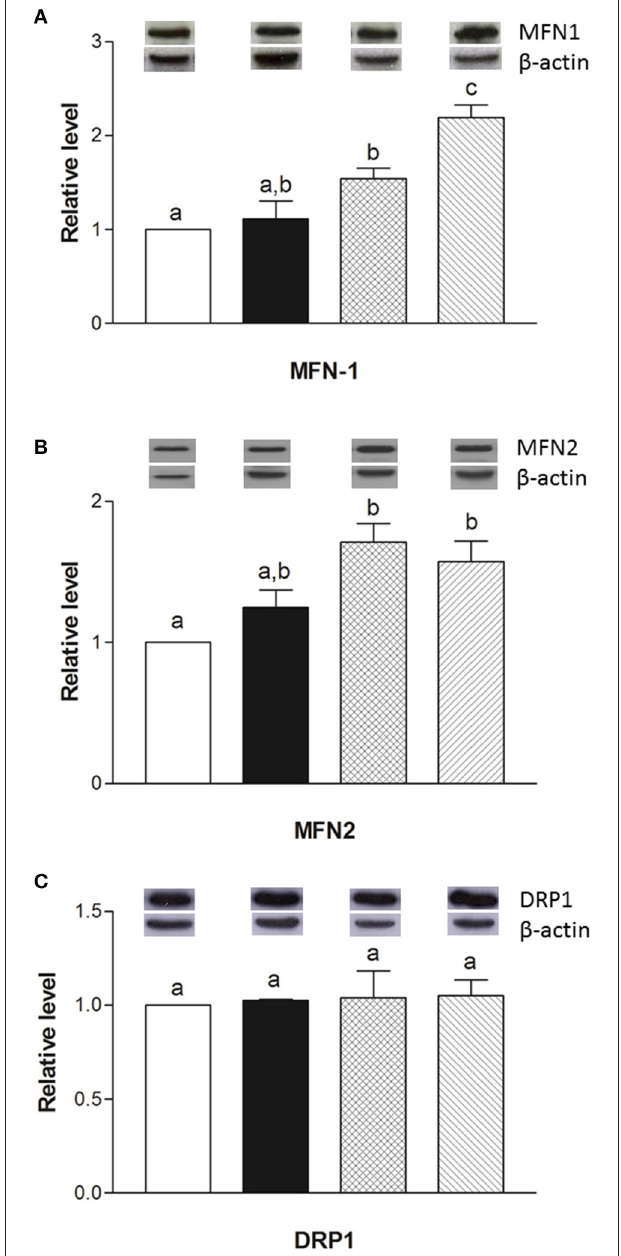
FIGURE 8 | Effects of oral administration of human, cow, and donkey milk on the protein levels of MFN1, MFN2, and DRP1. Results of the quantitative Western blot analyses for MFN1 (A) , MFN2 (B) , and DRP1 (C) were summarized. Protein levels of MFN1, MFN2, and DRP1 assessed in densitometry were normalized to the level of β -actin. Insets: representative immunoreactive signals for MFN1, MFN2, DRP1, and β -actin. Data are presented as means ± SEM from n = 7 animals/group. Labeled means without a common letter differ ( P <